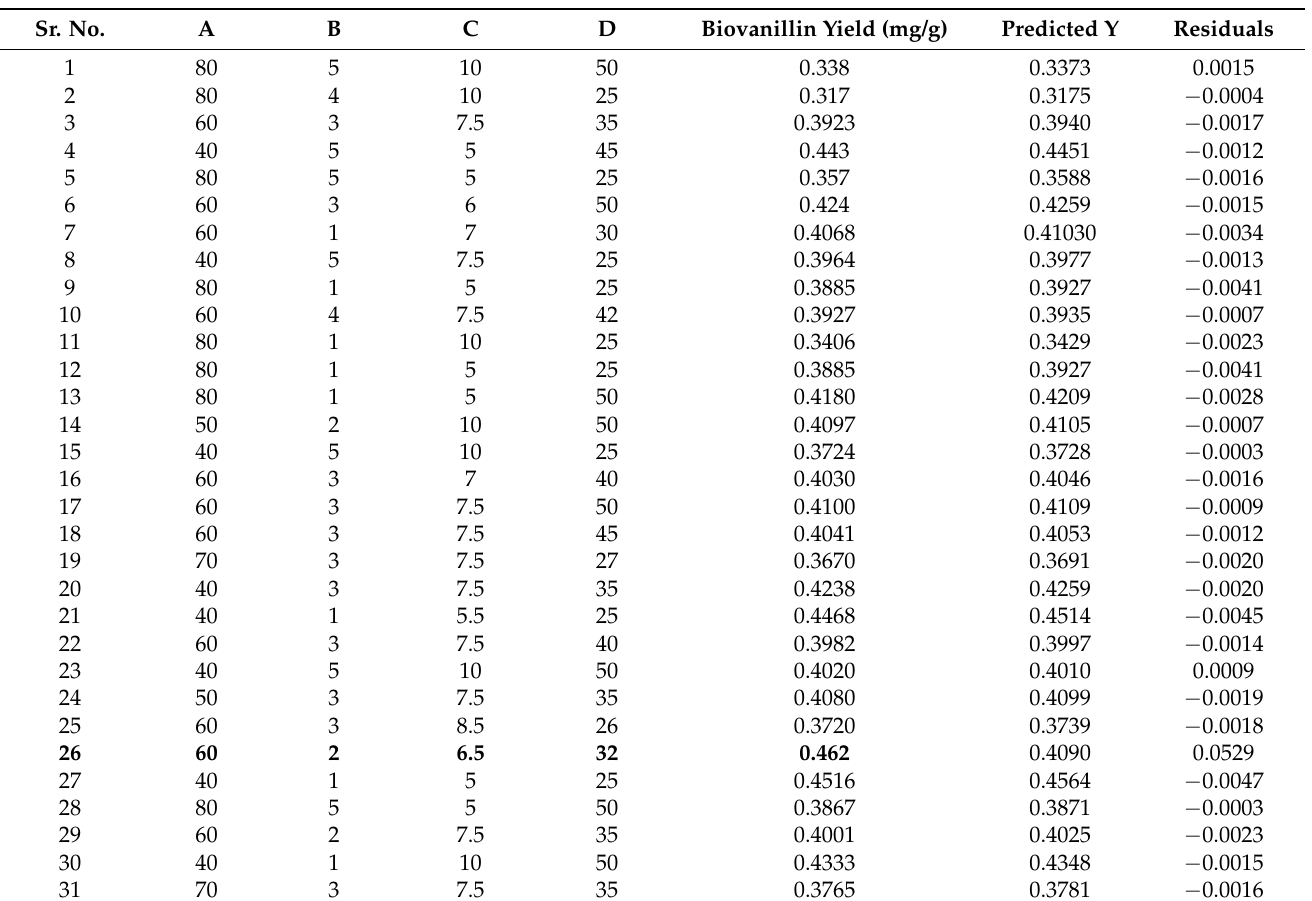
Table 2. Central composite design for the optimization of biovanillin using Punica granatum peels. Sr.